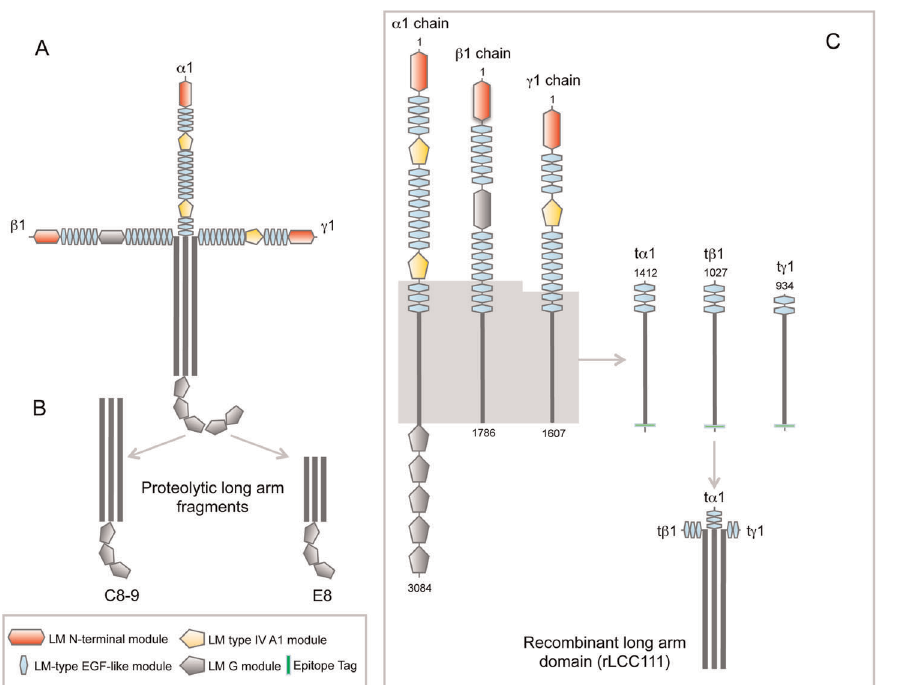
Figure 1. Schematic representation of structure of laminin-111 (A), and proteolytic fragments derived from the long arm (B) by elastase treatment (E8) and by cathepsin G treatment (C8-9). Schematic representation of the domain organization of laminin-111 and the recombinant laminin coiled-coil domain (rLCC111) used in this work (C). Amino acid positions are indicated according to the numbering of [44–46].